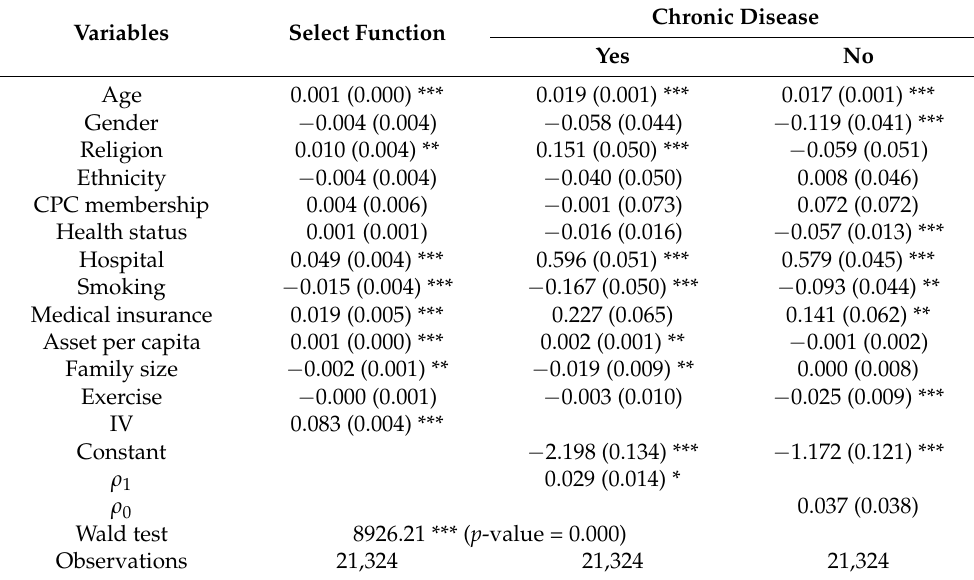
Table A4. The ESP model estimation for the effect of non-traditional fuel choices on Chronic disease.